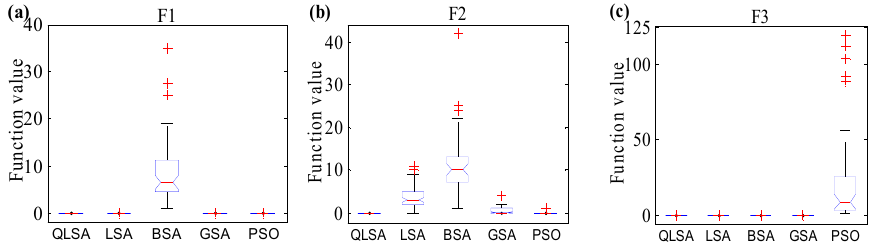
Figure 7. Variation in global optimization results for benchmark functions in Table 2. ( a ) F1; ( b ) F2; ( c ) F3.